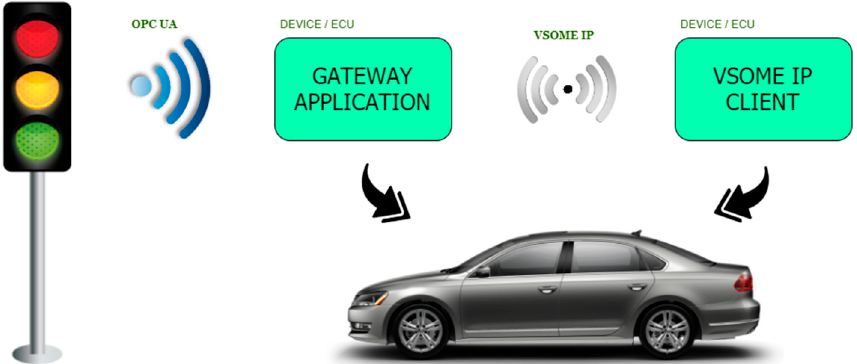
Figure 2. Case study general architecture.